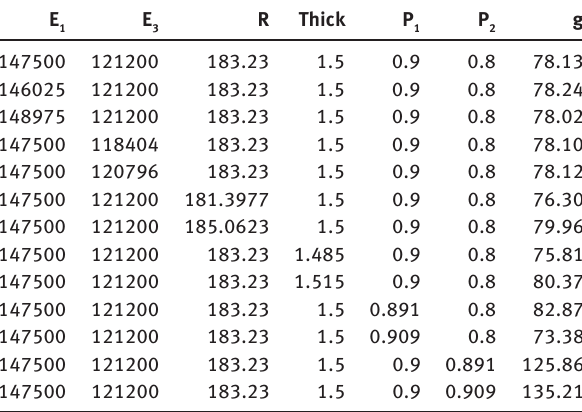
Table 4 Design points and LSF